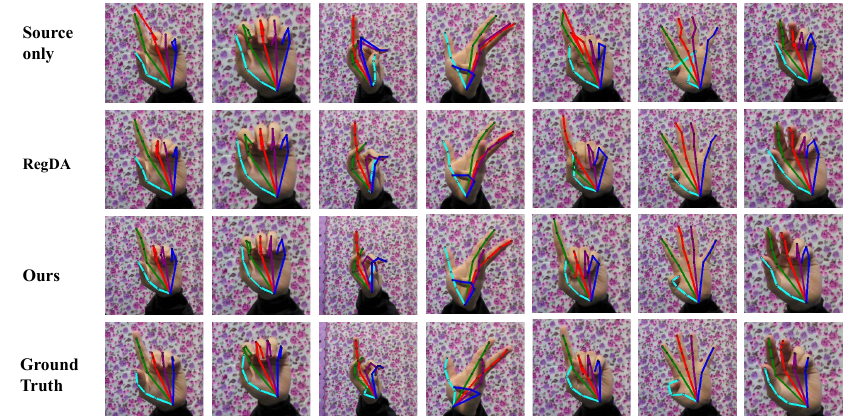
Figure 5. Qualitative results of different methods on the STB dataset.